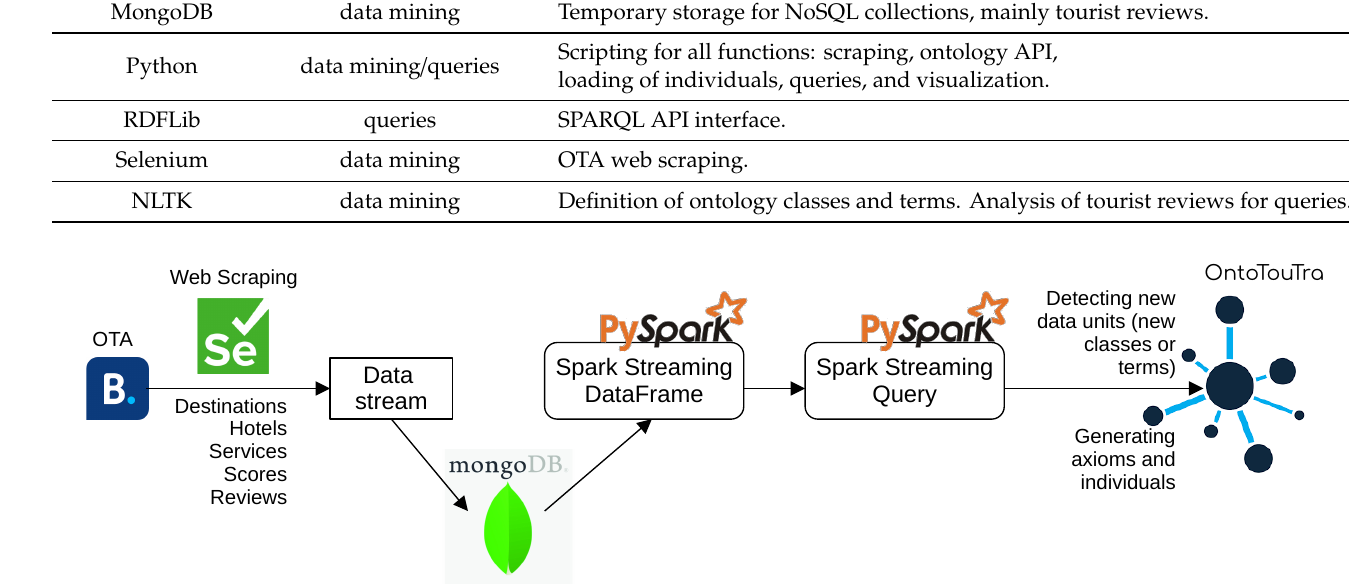
Figure 17. Architecture diagram for the data